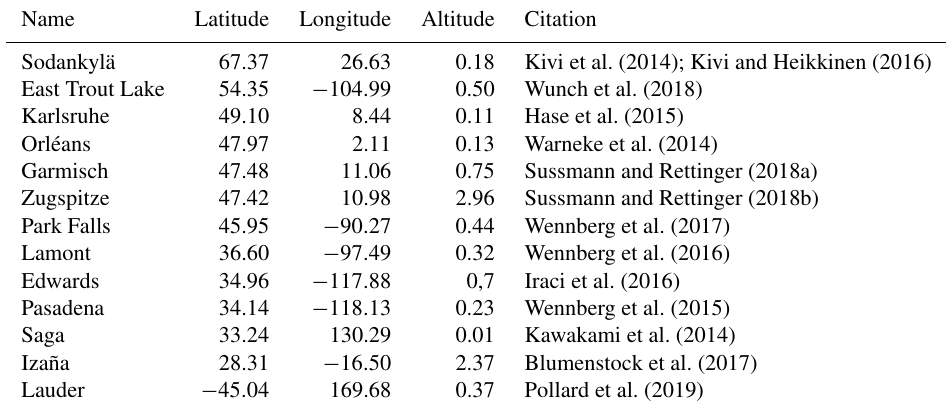
Table 2. Ground-based TCCON stations used for validation. The latitude and longitude values are given in degrees, and the surface elevation is given in